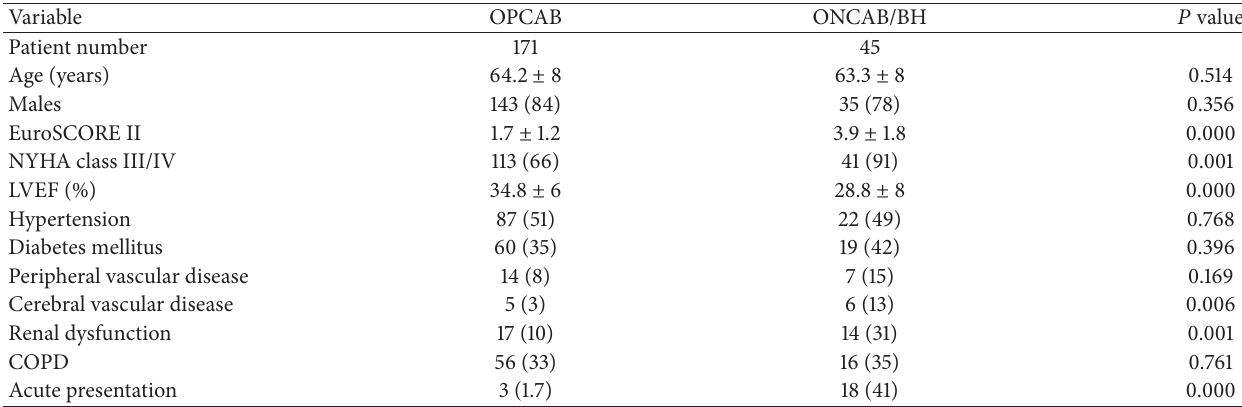
Table 1: Baseline and intraoperative risk